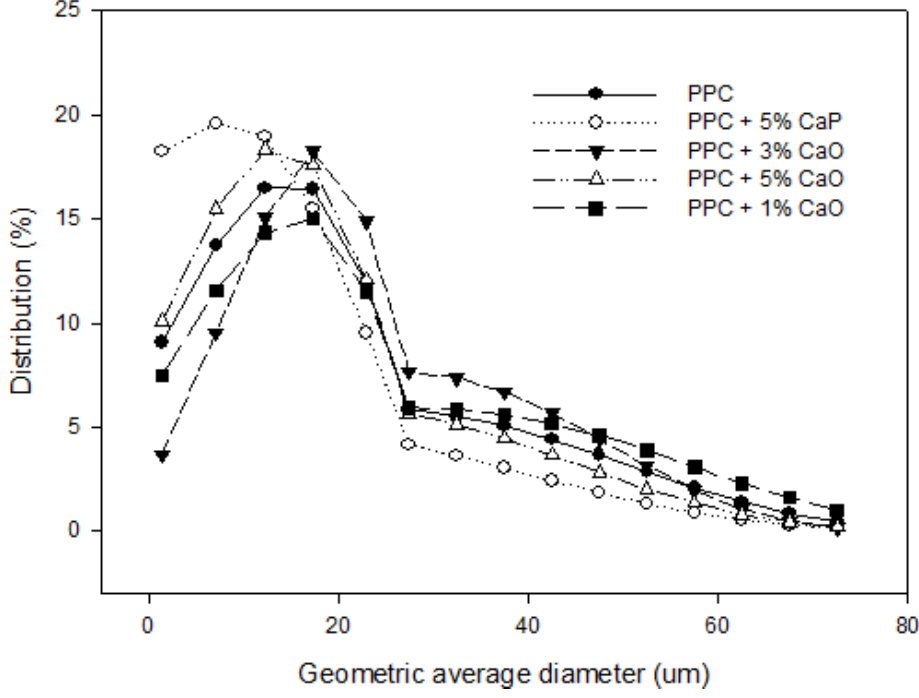
Figure 2. Size distribution of the various bioactive surface coating particles. Laser